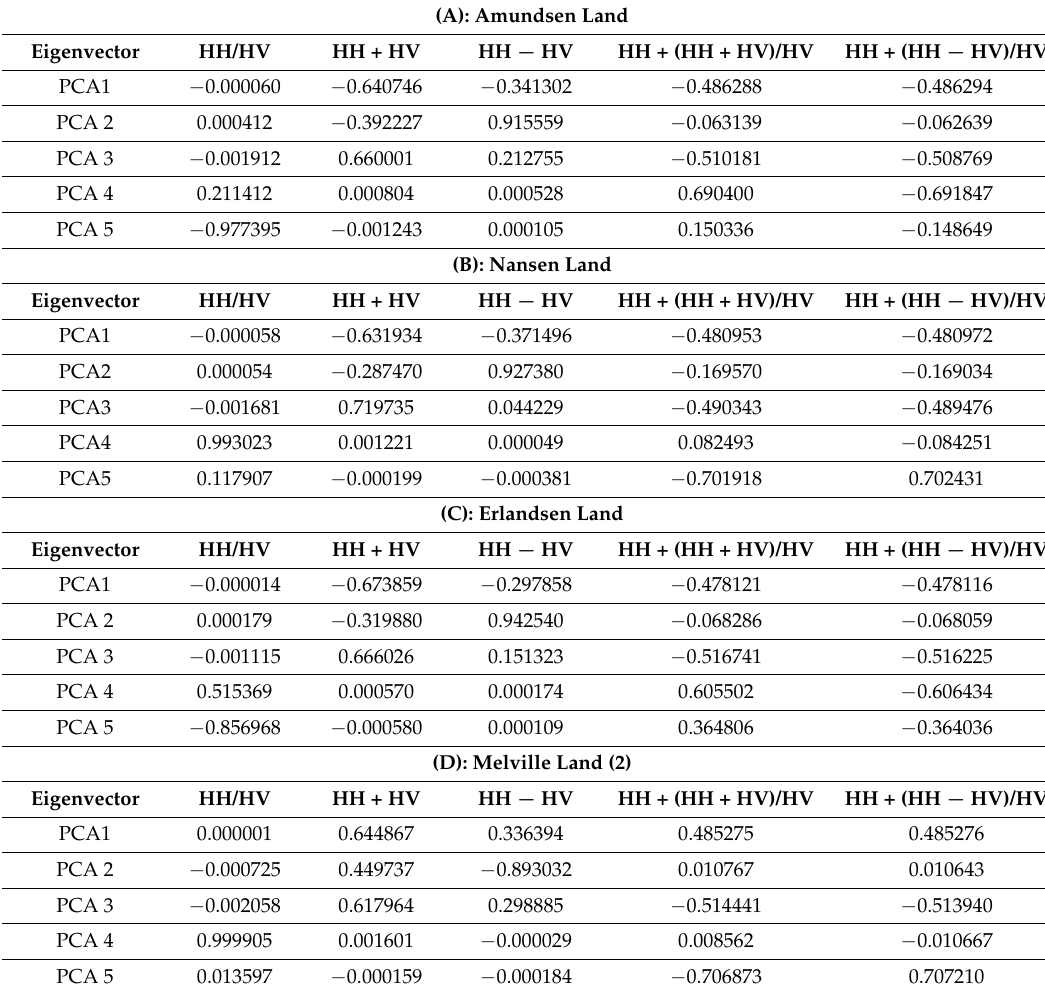
Table 4. Eigenvector matrix of the cross-polarized backscatter ratio images provides to the principal component analysis for PALSAR datasets, selected spatial subset scene covering (A) Amundsen Land, (B) Nansen Land, (C) Erlandsen Land, SW Peary Land, and (D) Melville Land (2), SE Peary